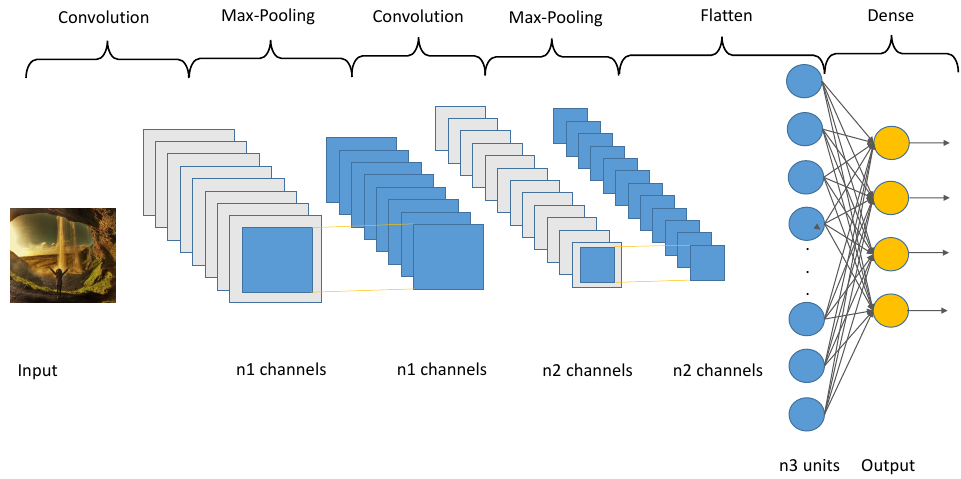
Figure 2. A vanilla Convolutional Neural Network (CNN)